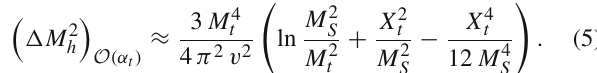
we plot in Fig. 2 the lines in the ( X t / M S , M S ) plane that, in our simplified scenario with degenerate SUSY masses, lead to the prediction M h = 125 . 1 GeV. Note that neither theory nor experimental uncertainties are taken into account in this example. The lower (blue) line corresponds to tan β = 20, while the upper (red) line corresponds to tan β = 5. The overall shape of the blue and red lines in Fig. 2 follows from the dependence on X t / M S of the Higgs-mass correction in Eq. (5). In particular, the value of M S required to obtain an acceptable prediction for M h is minimal for | X t / M S | ≈ 2, and it has a local maximum for | X t / M S | ≈ 0 (for very large / M | , on the other hand, the EW vacuum is unstable). | X t S Since for tan β = 20 the tree-level prediction for the lighter Higgs mass in Eq. (3) is essentially maximized, the blue line implies a lower bound on M S of about 2 TeV in this simpli- fied scenario. On the other hand, the comparison between the blue and red lines shows that, for lower values of tan β , larger stop masses are required to obtain M h ≈ 125 GeV,